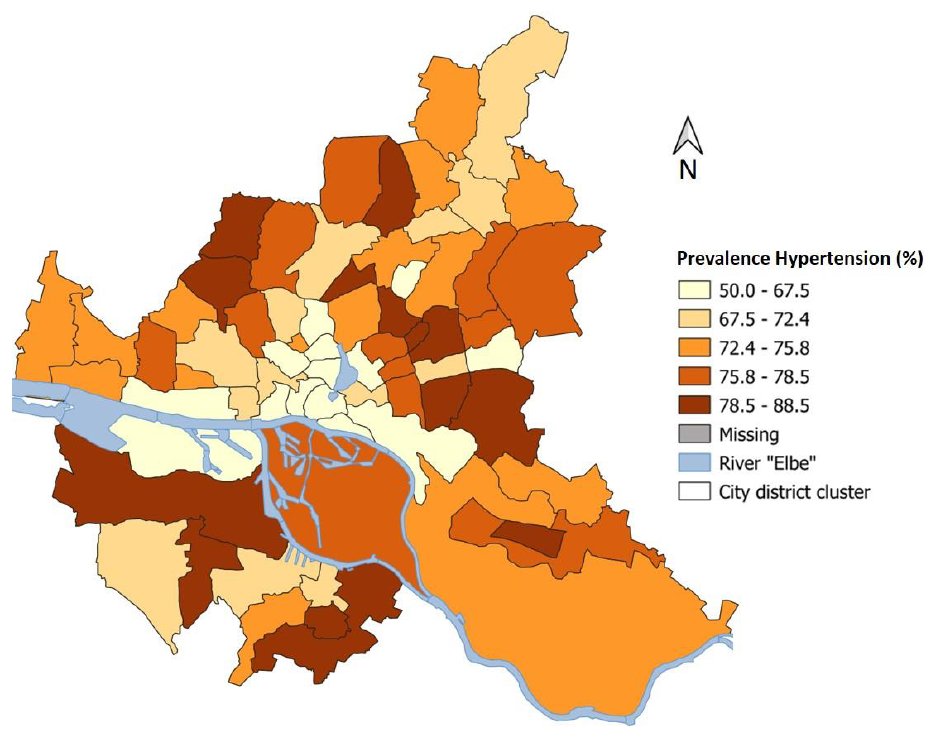
Figure 1. Prevalence of arterial hypertension (%) based on district clusters in Hamburg, adjusted for age, sex, educational status, smoking, and heart disease. Participants with at least five years of residence were considered.